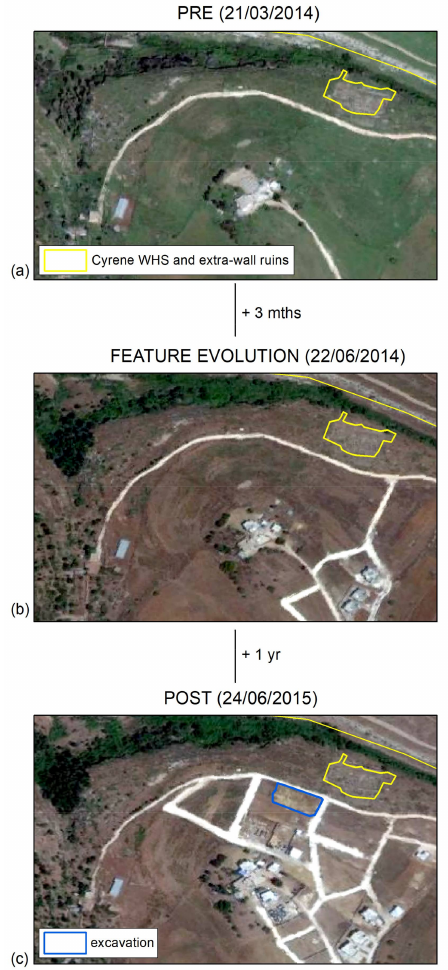
Figure 7. The evolution of the block feature detected in the proximity of the Sanctuary of Demeter and Kore, south of the Cyrene WHS hilltop site (see Figure 6c for location), based on the VHR Google Earth imagery time series: ( a ) 21 March 2014; ( b ) 22 June 2014; and ( c ) 24 June 2015. Google Earth imagery © 2018